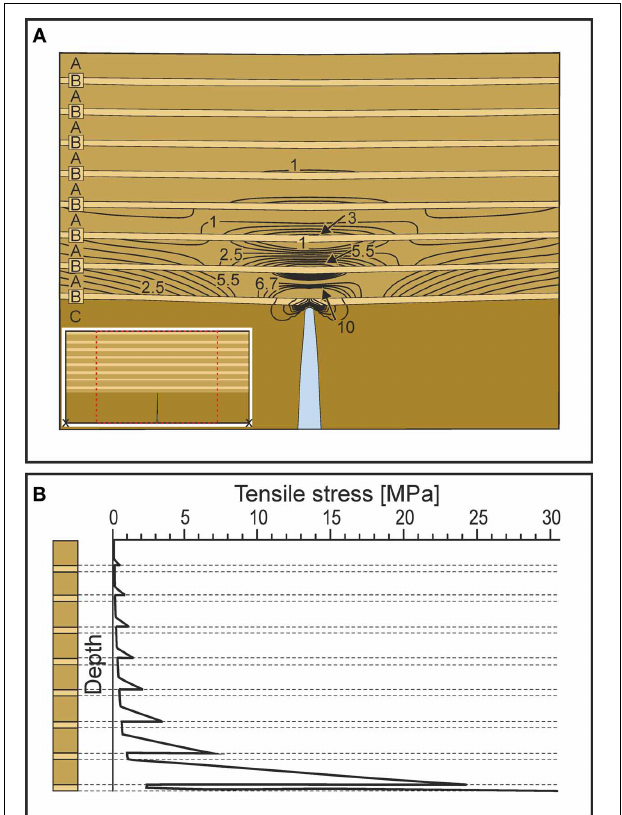
FIGURE 14 | Boundary-element model of the tensile stress around a hydrofracture in a mechanically layered crust. The inset in (A) shows the set-up of the model (cf. Figure 11 ): the hydrofracture tip is at 2 units below the surface. In this model, the crossed layers A (thickness 0.2 units) are stiff, Young’s modulus E 100GPa, the dotted layers B (thickness 0.05 units) are very soft, E = 1GPa; in layer C Young’s modulus is 40GPa. Poisson’s ratio is 0.25 in all the layers. (A) Concentration of the maximum principal tensile stress σ 3 , in mega-pascals (truncated at 1 and 10MPa). The aperture of the hydrofracture is shown 150 times exaggerated and is largest in the soft layers. As the hydrofracture tip meets with the bottom of a soft layer, it becomes wide and blunt. There is high tensile stress concentration in the stiff layer above that could induce new fractures. However, only in a small area in the soft layer next to the hydrofracture, the tensile stress exceeds 10MPa. (B) Tensile stress distribution from the surface to the hydrofracture tip. Apart from the general increase of the tensile stress from zero at the surface to the tip, the tensile stress increases in the lower parts of all the stiff layers and is relatively lowest in all the soft layers with abrupt changes at the contacts between stiff and soft layers. The highest tensile stress, 30MPa occurs at the fracture tip, but this value is much lower than the tip stress for the homogeneous model ( Figure 11B ).